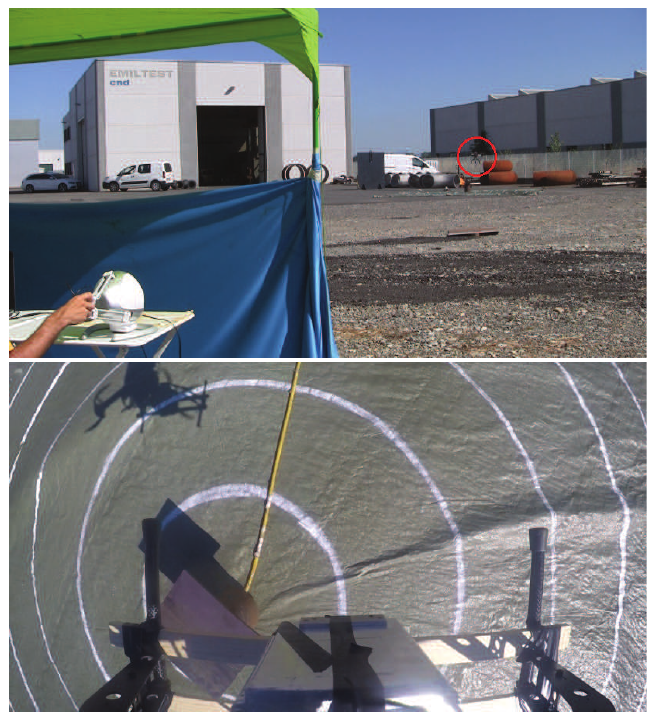
Figure 12. Detection of 192 Ir (located at the center of the target within the lead container) in a real environment using the position to position teleoperation mode. Experimental setup (top), where the UAV is highlighted by the red circle. Image taken from the onboard camera (bottom) when the operator affirmed that the current position of the UAV returned the maximum measured radiation. In this set of experiments, the gimbal unit was not used to get a clearer view of the ground from the onboard camera. The low speed of the UAV ensured that the gamma-ray detector remained parallel to the